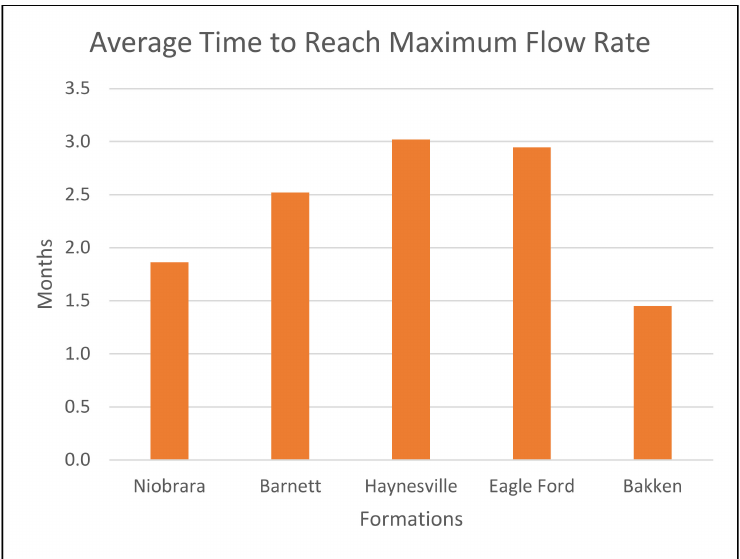
Figure 8. Average time to reach maximum flow rate for all wells from each